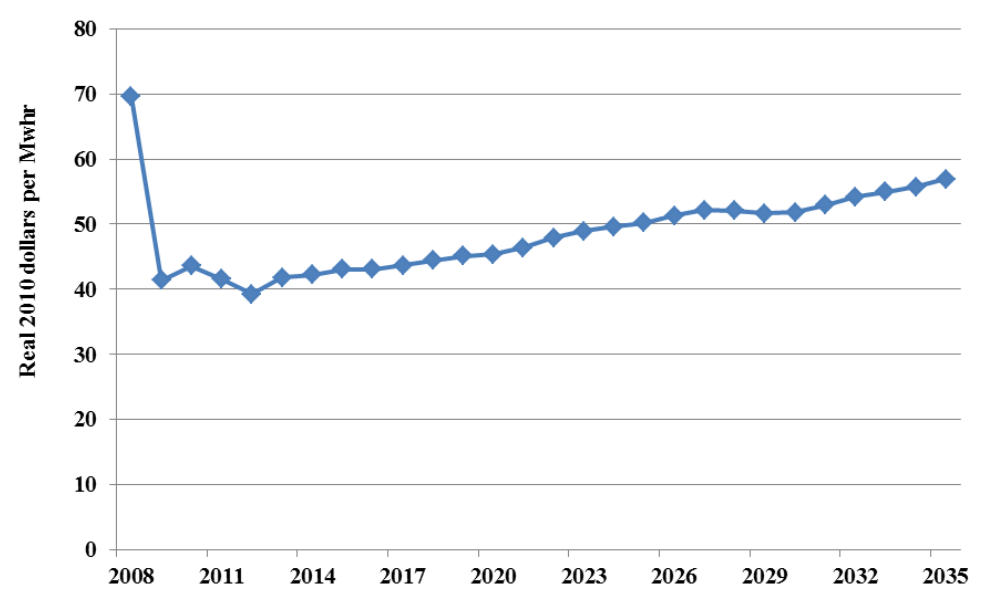
Figure 4. Levelized costs of new natural gas generation